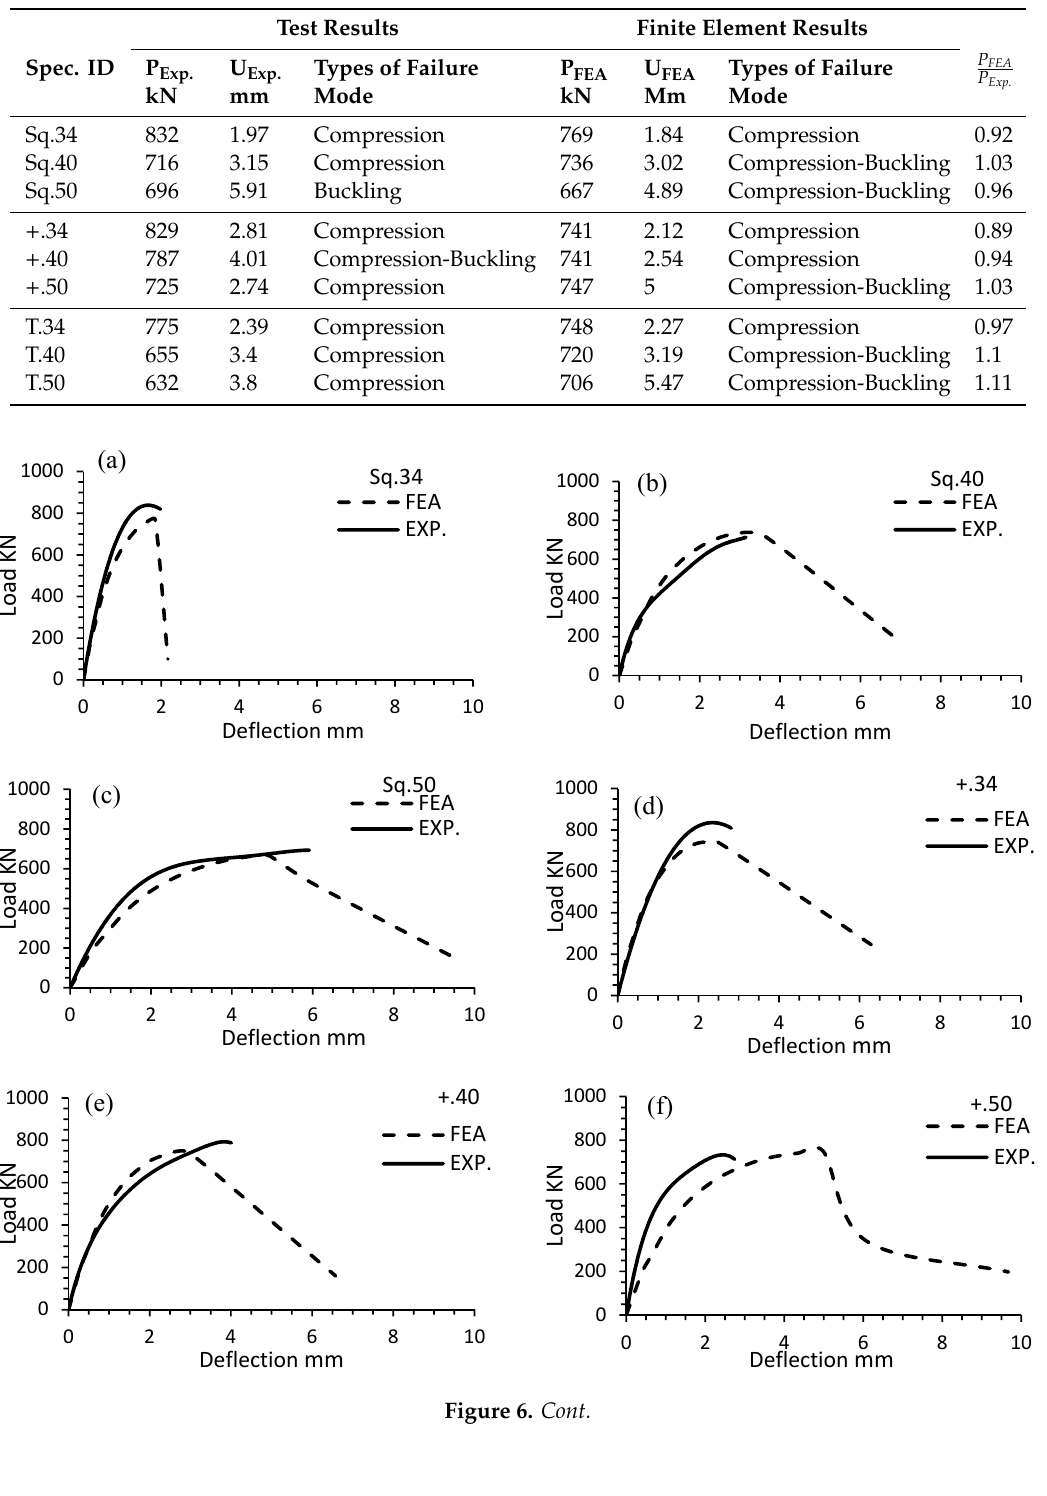
Figure 6. FE results of specimens: (a-c) Sq. shaped columns with different slenderness ratios ; (d-f) +. shaped columns with different slenderness ratios ; (g-i) T.shaped columns with different slenderness ratios